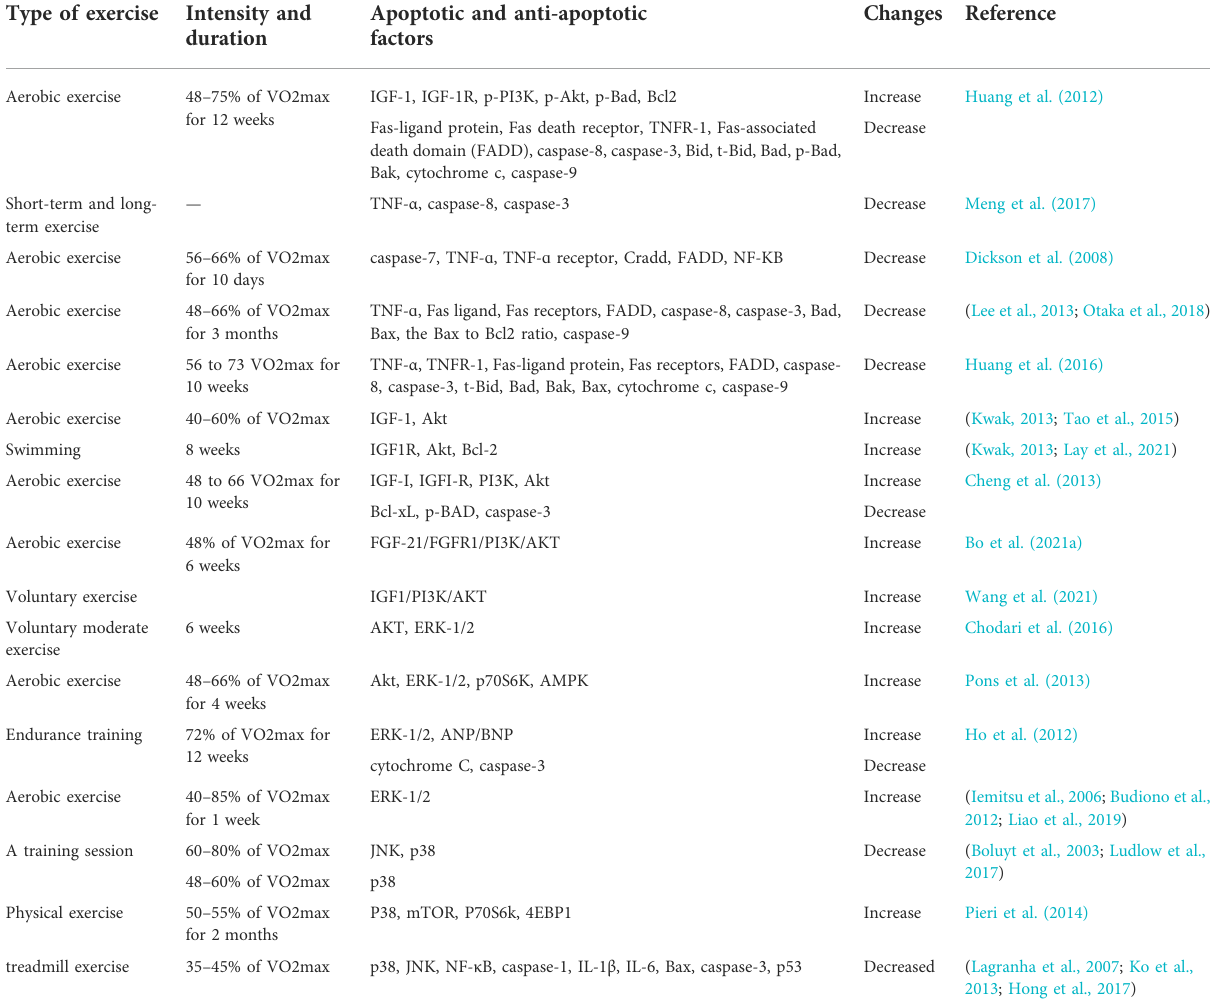
TABLE 1 A summary of exercise studies on the factors affecting cardiac